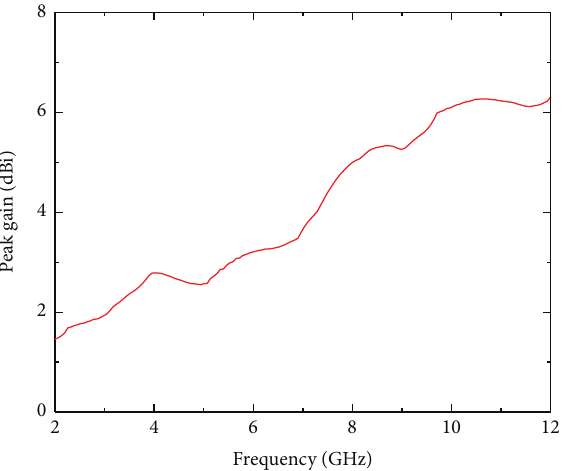
Figure 6: Simulated peak gain of the single UWB antenna without EBGs.